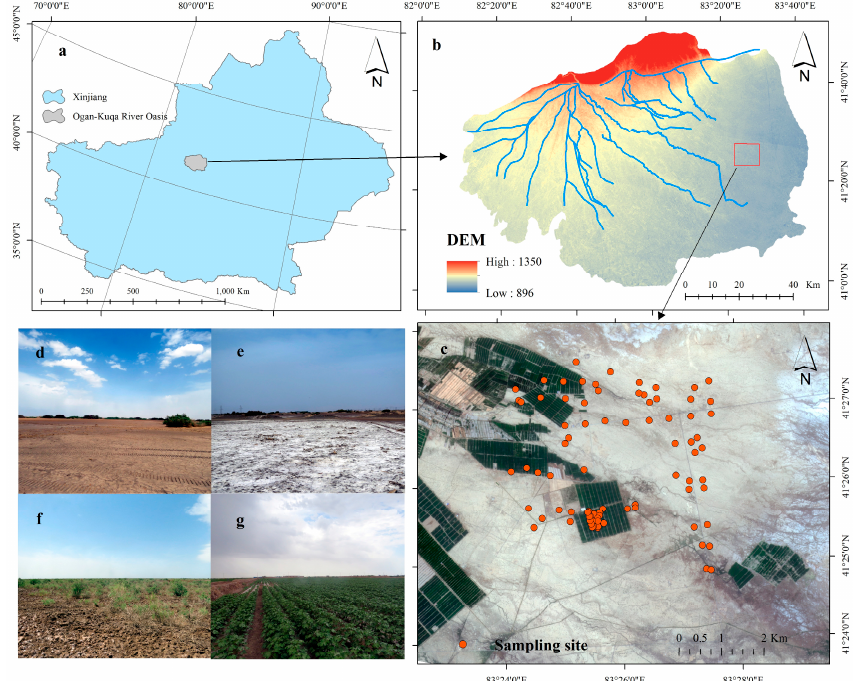
Figure 1. Location of the study area. ( a ) The sampling area is in Xinjiang, China. ( b ) The study location is at the intersection of farmland and desert in the Ogan-Kucha River Oasis, with Digital Elevation Model (DEM) data in the background. ( c ) Locations of sampling sites. ( d – g ) The main surface types at the sampling sites, in order of preference, are desert, salt crust, desert vegetation, and